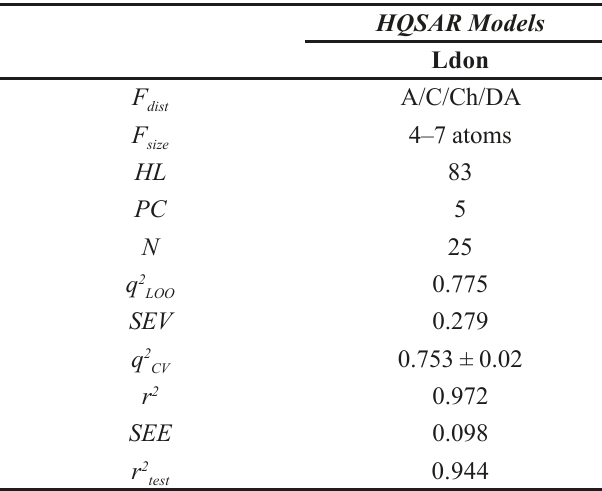
TABLE I - Model data generated from Leishmania donovani